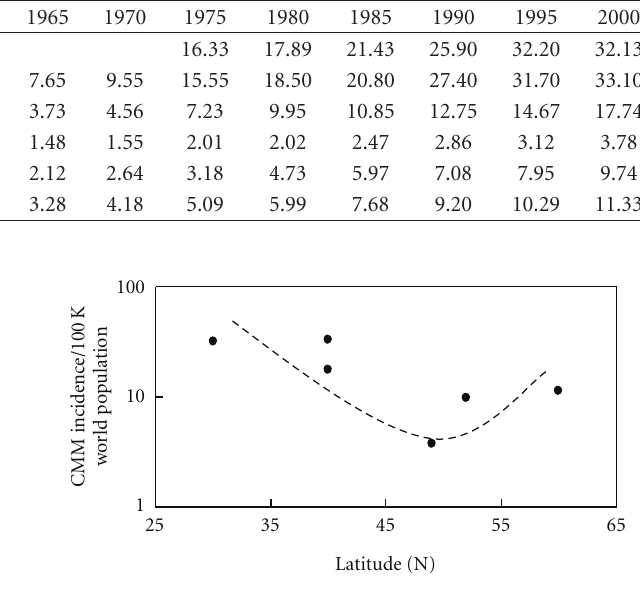
Figure 2: The incidence of CMM in the world’s white populations for the year 2000 based on IARC data. The trend line indicates an increasing exponential incidence with decreasing latitude; however, a reversal appears to occur above ∼ 50 ◦ N where the incidence increases with increasing latitude. Both Northern Europe and New Zealand, where there is ozone depletion, only have linear increases in the incidence of CMM; whereas, everywhere else in the world the increasing incidence is exponential. Note that in Northern Europe only Iceland has an exponential increase in